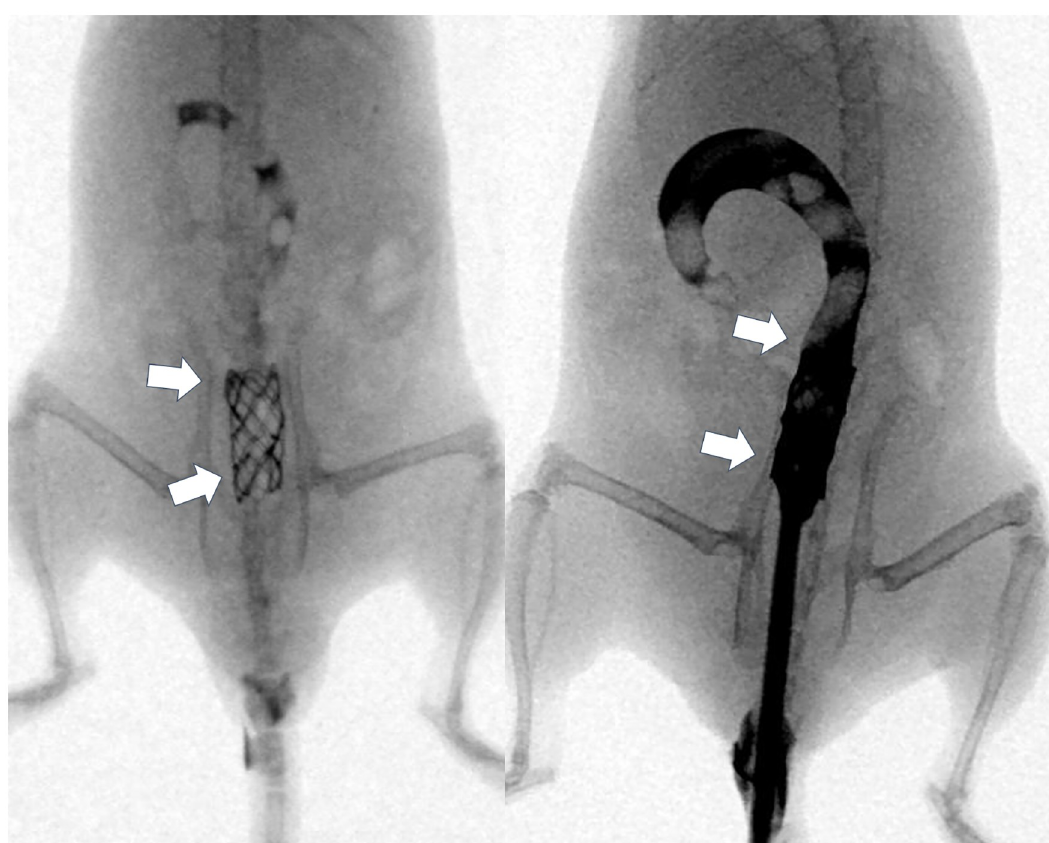
Fig 2. Representative radiographic images showing the stent in the sigmoid colon at the level of the pelvis. [Arrows = stented sigmoid colon at the level of the